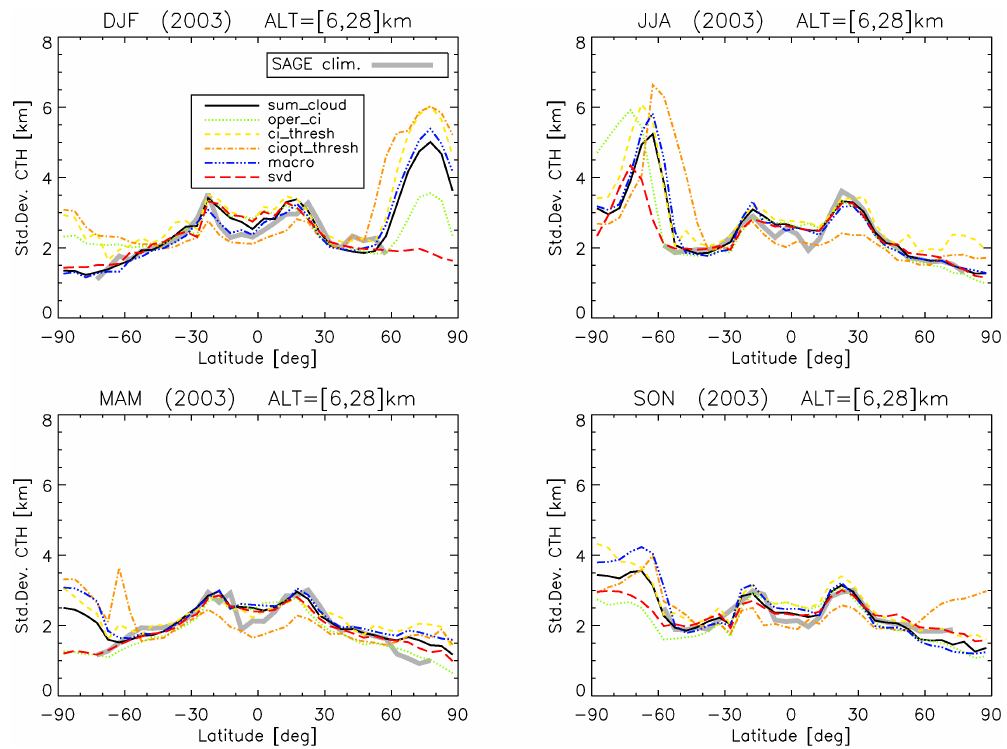
Fig. 13. The standard deviation of the zonal mean CTH for various detection methods above 4km altitude for the spring, summer, autumn and winter seasons in the 2002 (December) to 2004 (January–November) time